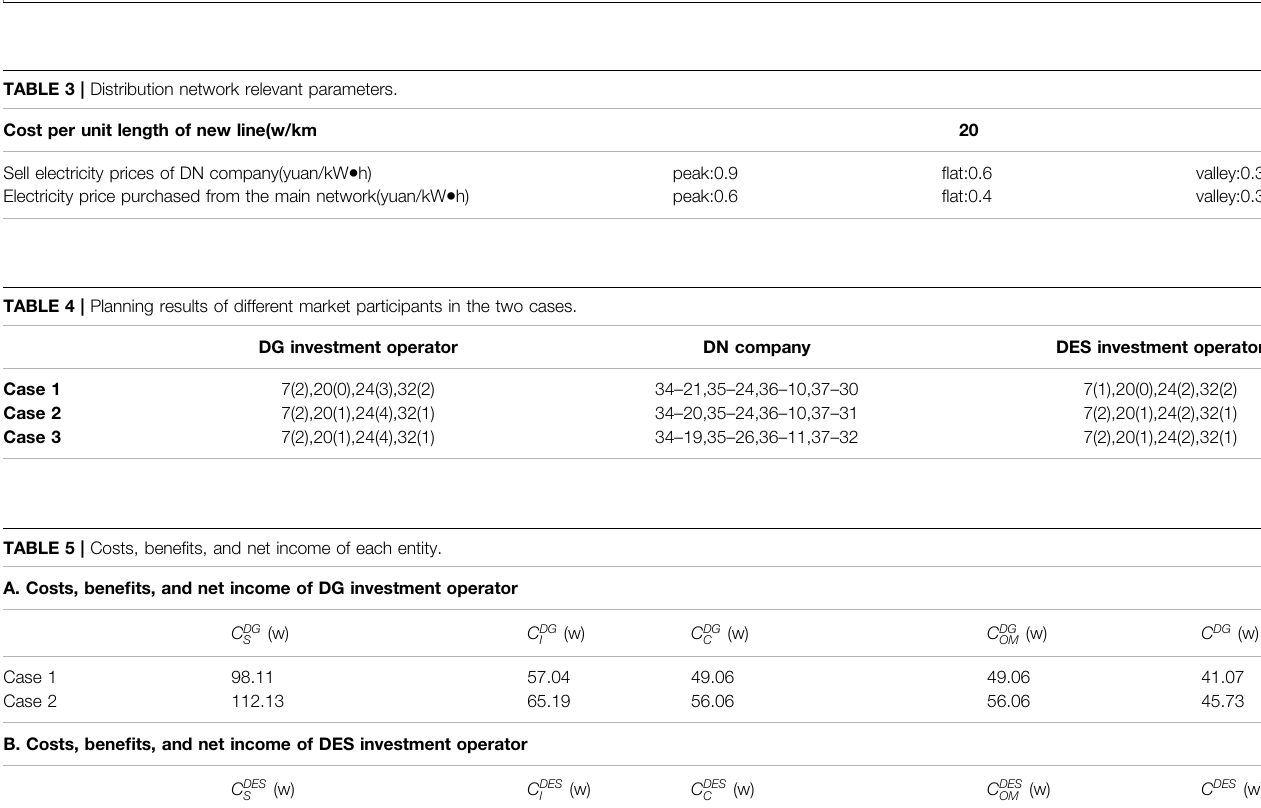
FIGURE 1 | IEEE33 node distribution system.